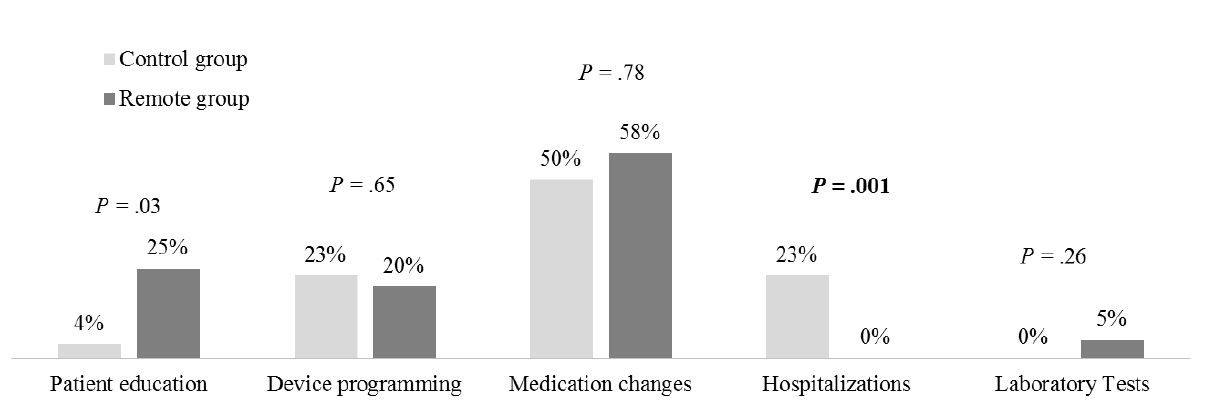
Figure 5. Distribution of specific clinical actions related to device-detected events in the Remote group (n=43) and in the Control group (n=26)